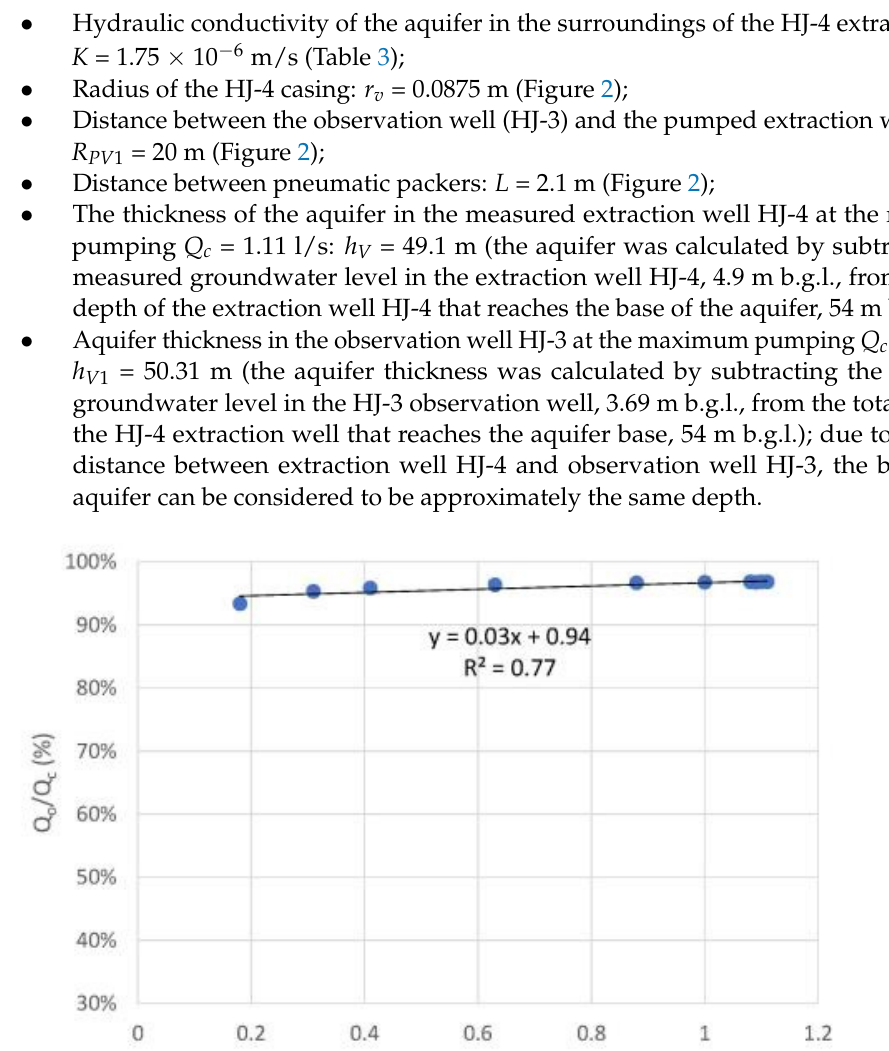
Table 7. Pilot test on the HJ-4 extraction well on 2 July 2020.